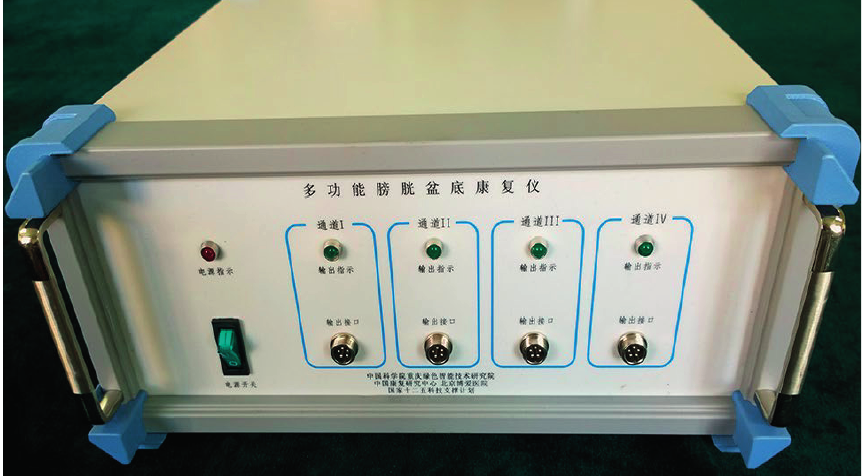
Figure 10. Bladder-Pelvic